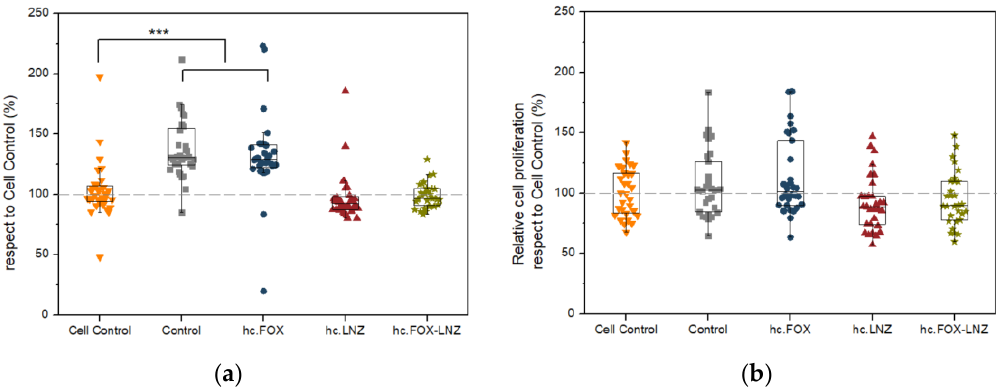
Figure 9. Percentage of MC3T3-E1 ( a ) viability and ( b ) proliferation without treatment (Cell Control) or treated with Control, hc.FOX, hc.LNZ, or hc.FOX-LNZ sol–gel coatings. Data are represented as median and interquartile range of the percentage of viability and cellular proliferation, respectively.